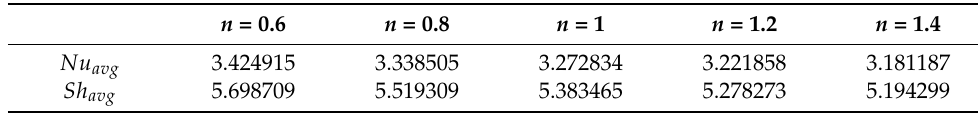
Table 4. Average Nu and Sh comparison.